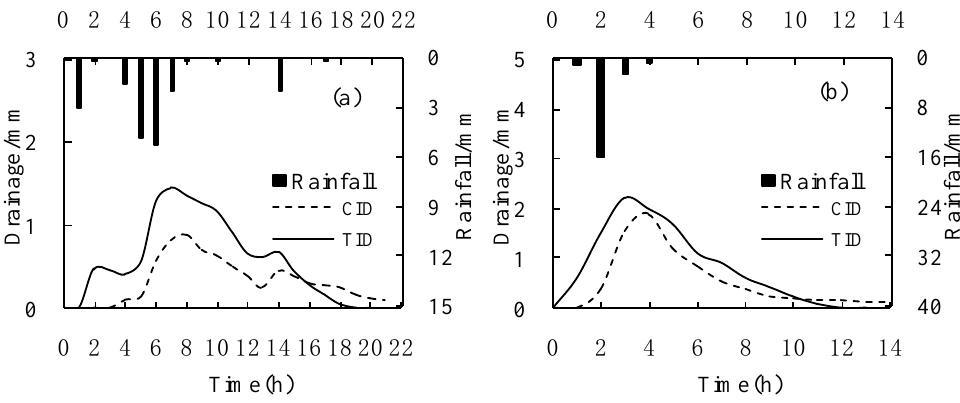
Figure 2. Individual rainfall runoff on 21 July ( a ) and 25 August ( b ).